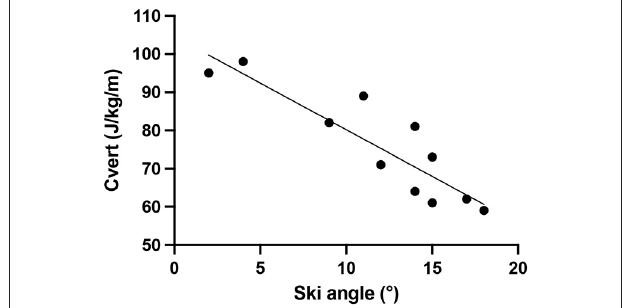
FIGURE 4 | Mean vertical energy cost for the various sections of the 3 main climbs on the PDG as a function of the slope angle for athlete #1. R 2 = 0.78, P <